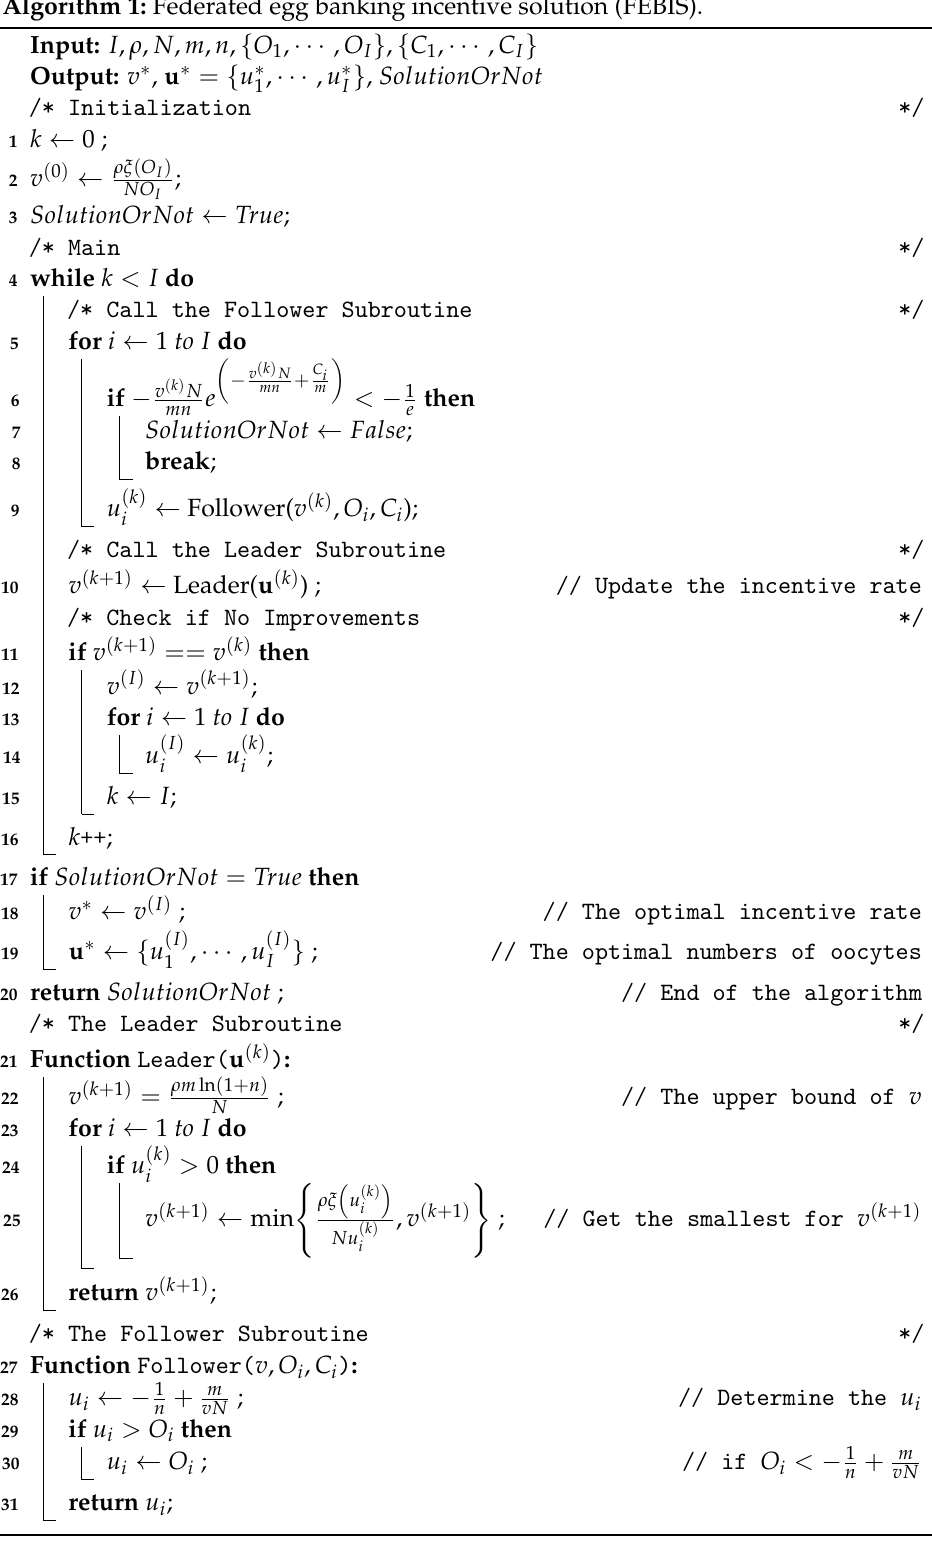
Algorithm 1: Federated egg banking incentive solution